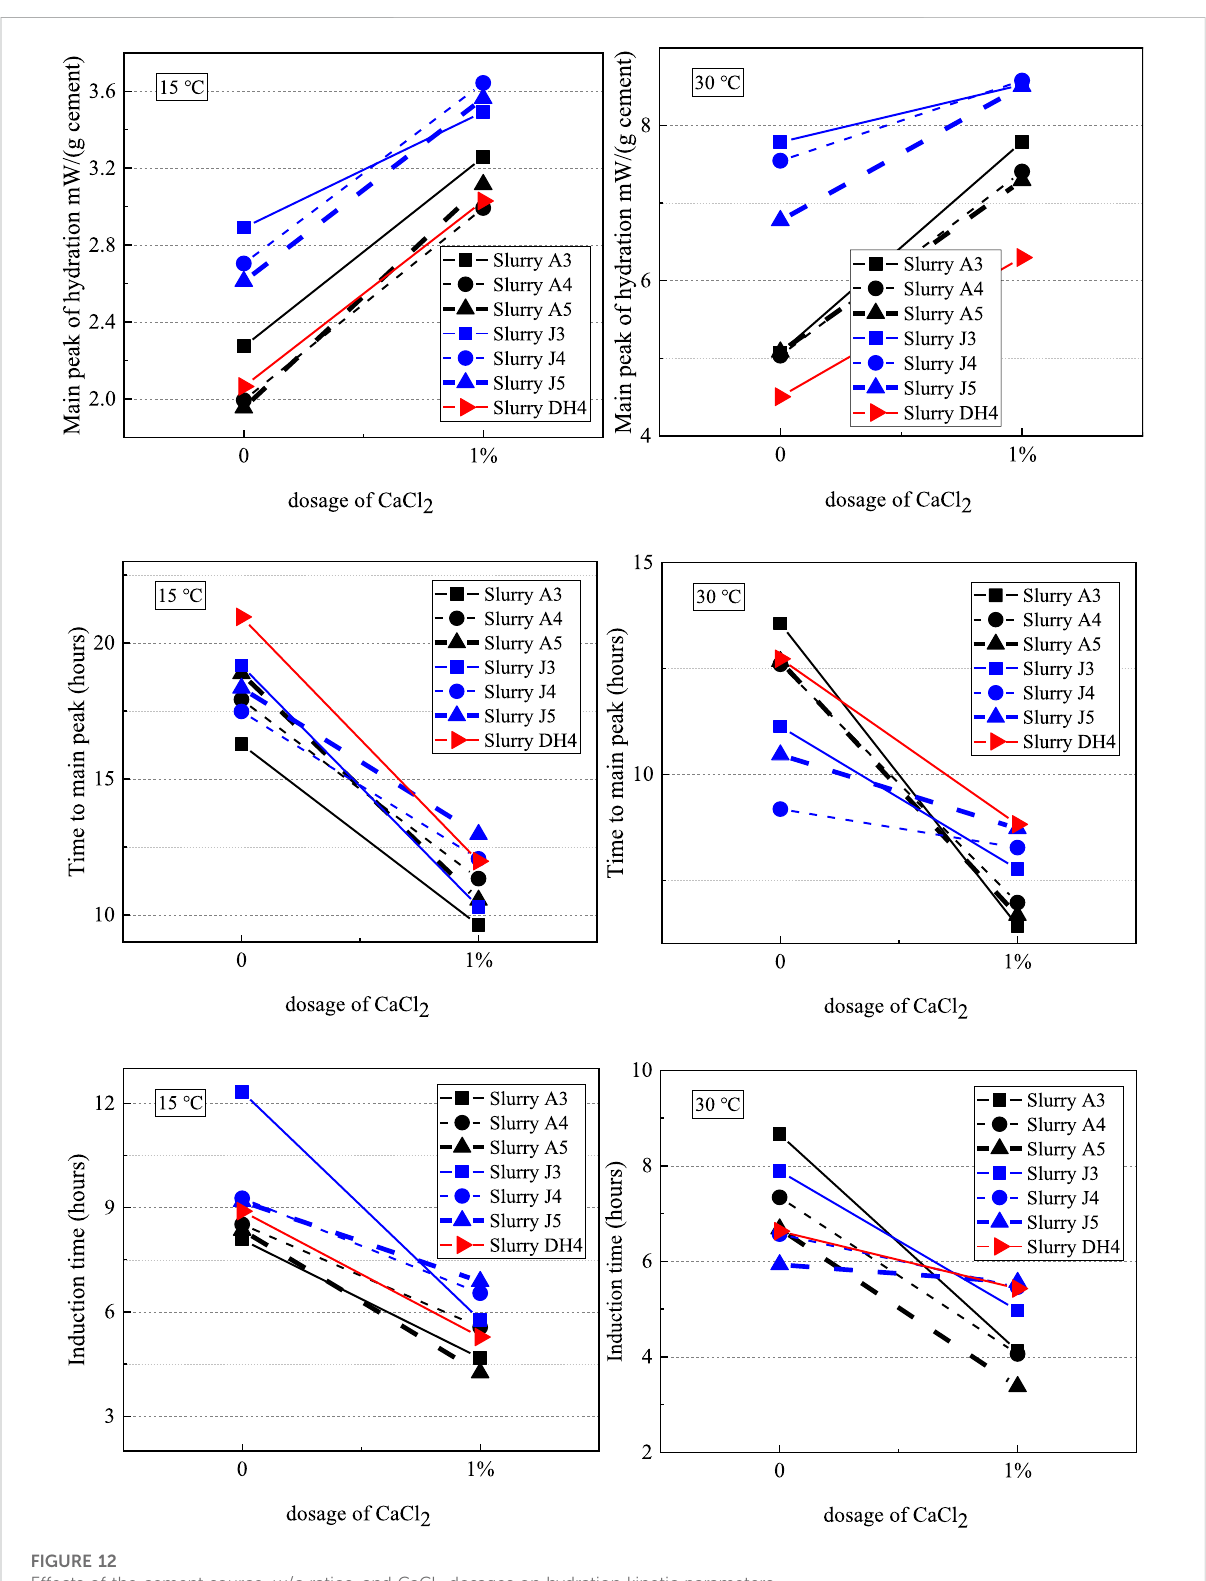
FIGURE 12 Effects of the cement source, w/c ratios, and CaCl 2 dosages on hydration kinetic